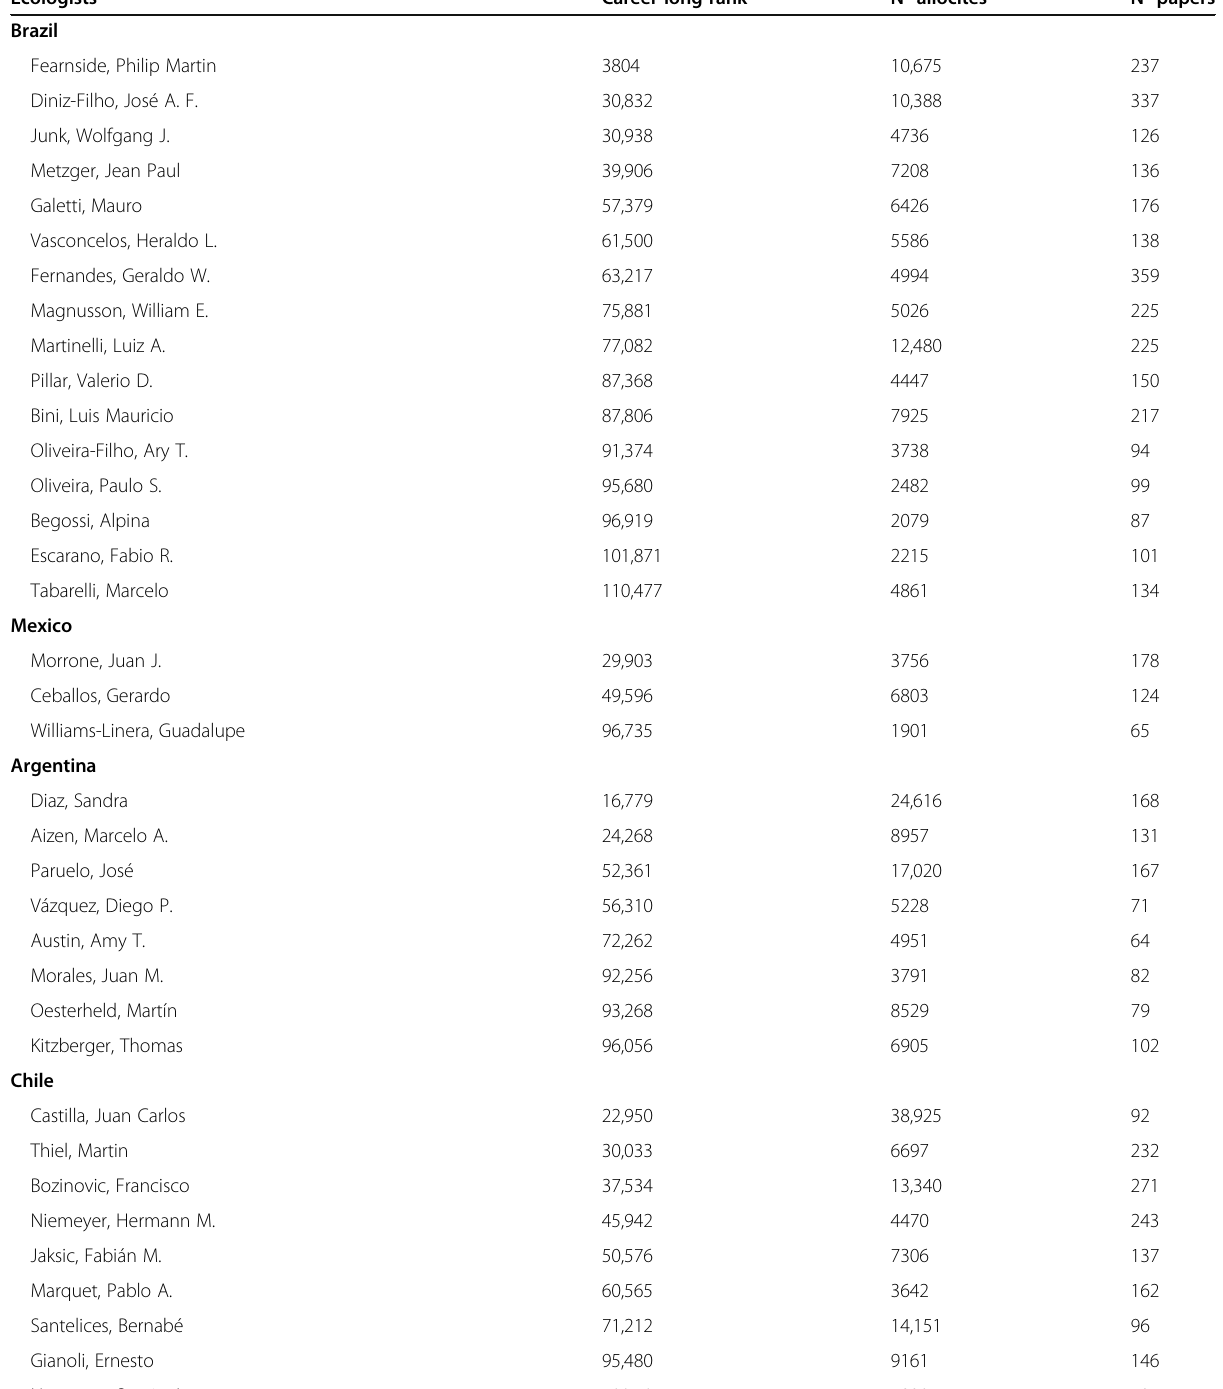
Table 1 Whole trajectory (Career-long) impact ranking of Latin American ecologists, No. allocites, and No. papers in the Scopus database, based on Table S-6, Career-long ranking, by Ioannidis et al. [3]. Here and elsewhere countries in decreasing order by total population size (Table 7). For the global sample, countries are identified by their ISO 3166